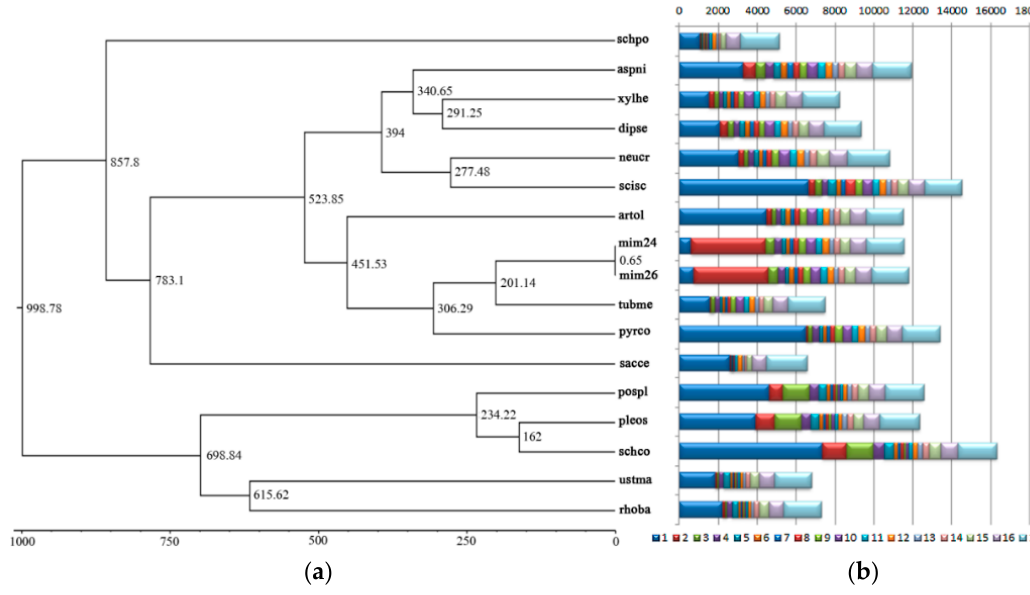
Figure 3. Evolutionary divergence time and statistical analysis of homologous genes in 17 species. ( a ) The maximum-likelihood method and LG + I + G + F model were used to construct the phylogenetic tree using 1072 single-copy genes identified from the two different monospore strains and 15 reference species. The abscissa unit was million years ago (Mya); the 15 species were schpo Schizosaccharomyces pombe , aspni Aspergillus niger , xylbe Xylona heveae , dipse Diplodia seriata , neucr Neurospora crassa , sclsc Sclerotinia sclerotiorum , artol Arthrobotrys oligospora , mlm24 Morchella importuna M04M24, mlm26 Morchella importuna M04M24, tubme Tuber melanosporum , pyrco Pyronema confluens , sacce Saccharomyces cerevisiae , pospl Postia placenta, pleos Pleurotus ostreatus , schco Schizophyllum commune , ustma Ustilago maydis , and rhoba Rhodotorula graminis (The reference genome used in this paper was downloaded from the Joint Genome Institute (JGI) website https://genome.jgi.doe.gov/programs/fungi/, Table S11). ( b ) The number of homologous genes of the corresponding 17 species is displayed by the stacking column pattern, and the number of homologous genes that appeared in the corresponding number of species is expressed in different colors.